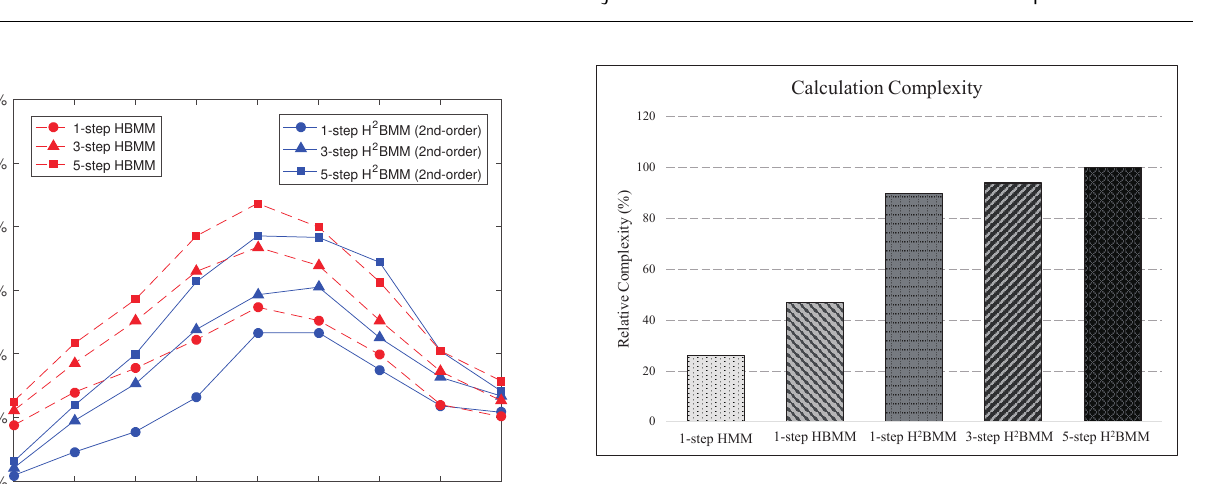
Figure 9. Computation Complexity of HMM, HBMM and H 2 BMM